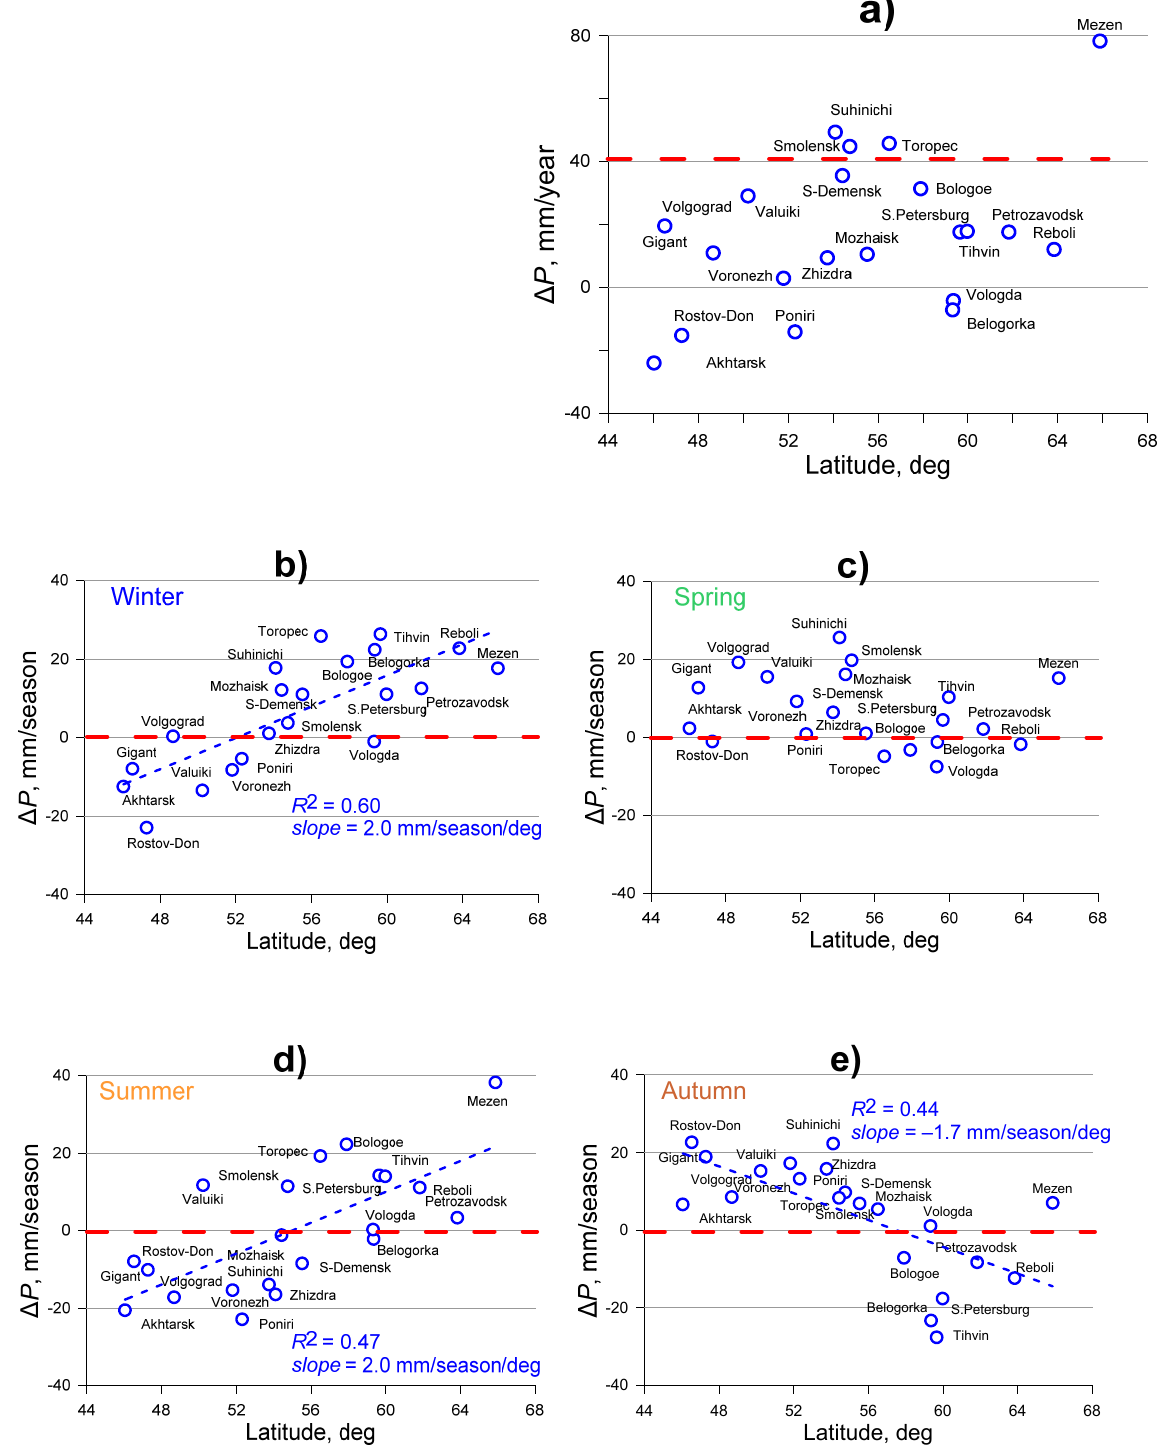
Figure 5. Latitudinal changes in long-term average annual ( a ) and seasonal ( b )-( e )precipitation ∆ P in modern period and their linear trends (blue dashed lines).